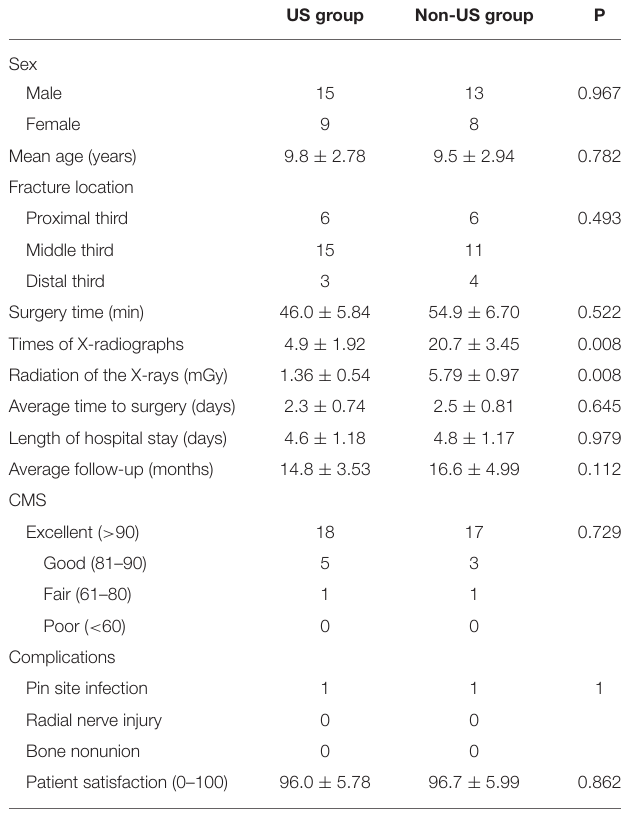
TABLE 1 | Demographic characteristics and clinical data of the